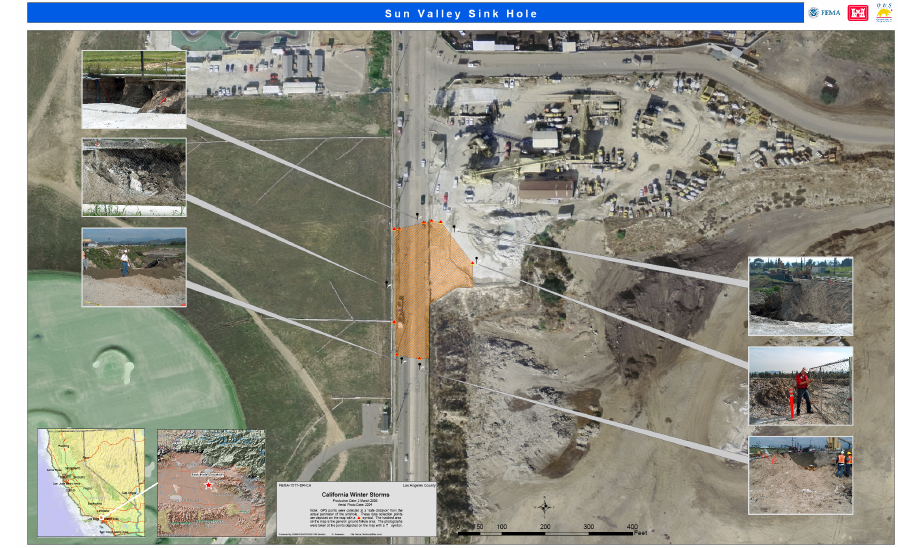
Figure 5 – Application of GIS in emergency